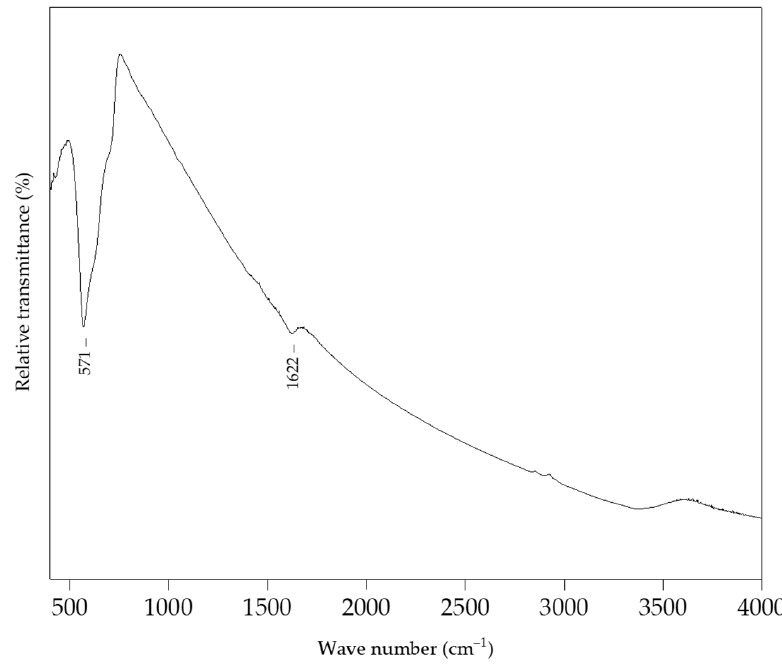
Figure 9. FTIR spectrum of magnetite NPs.